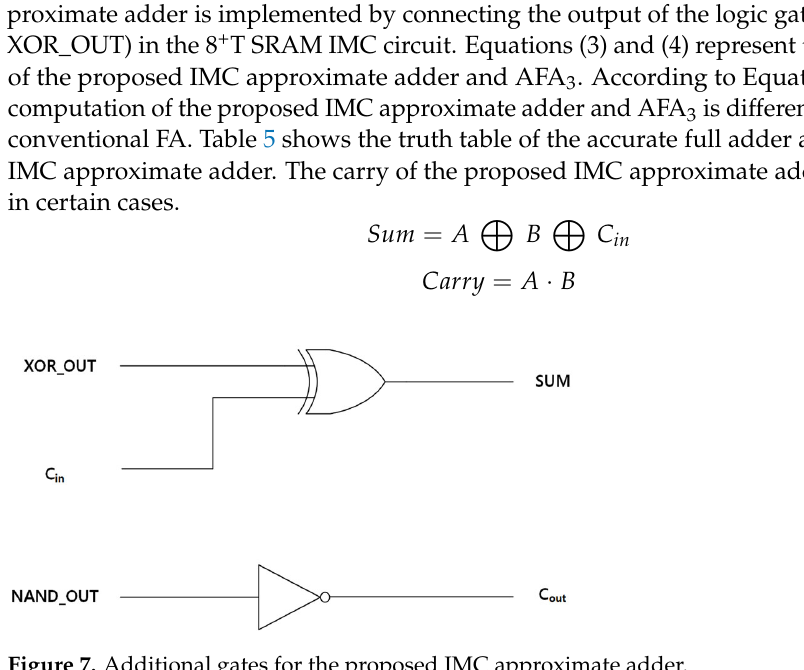
Figure 7. Additional gates for the proposed IMC approximate adder.